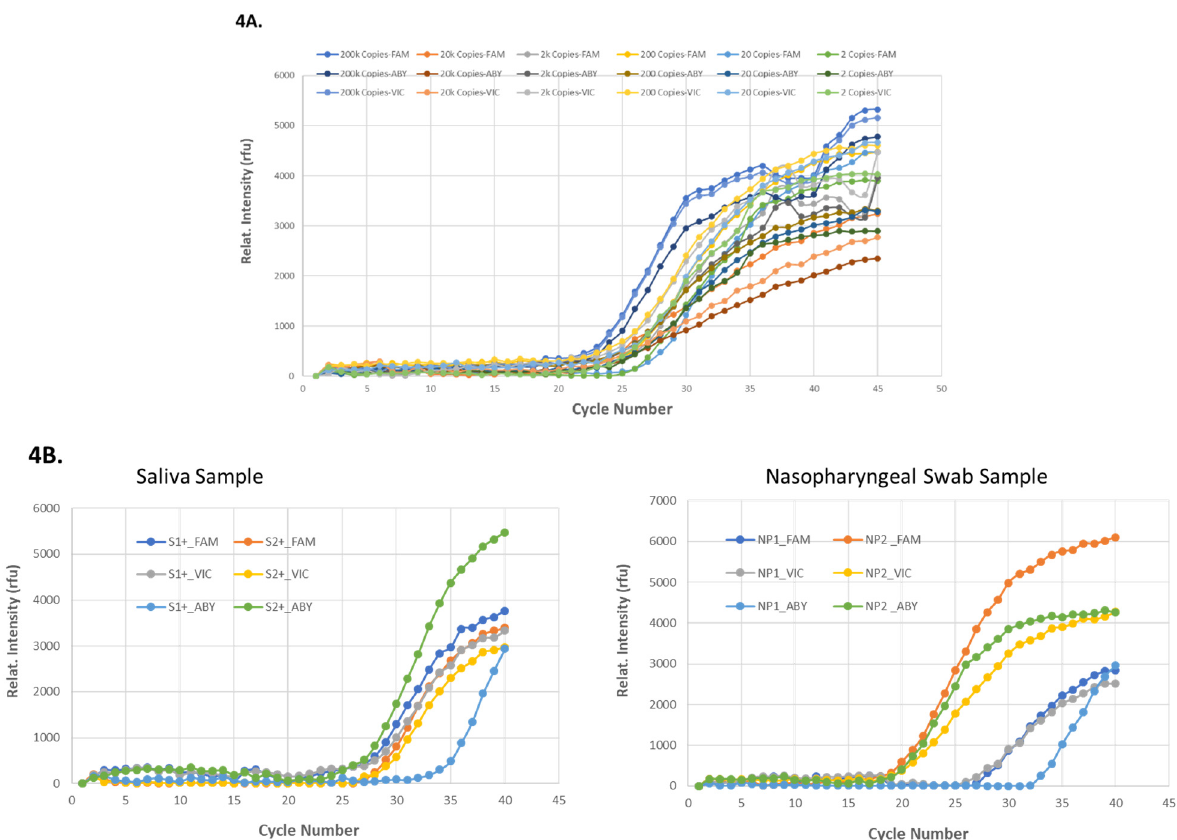
Figure 4. On-chip 1-step multiplex RT-qPCR on-MiDAS. The on-chip 1-step multiplex RT-qPCR with N1-FAM, N3-ABY, and RNP-VIC primers was tested with templates of different concentrations (copy numbers) of 2019-nCoV N Plasmid-RNA ( 4A ) and the purified SARS-CoV-2 RNA of unknown concentration from clinical patients’ saliva and nasopharyngeal swab specimens ( 4B ). Notations of S1+ and S2+ are saliva specimens ( 4B left panel ), NP1 and NP2 are nasopharyngeal specimens ( 4B right panel ). N1 primer is labeled with FAM, N3 is labeled with ABY, and RNP is labeled with VIC.